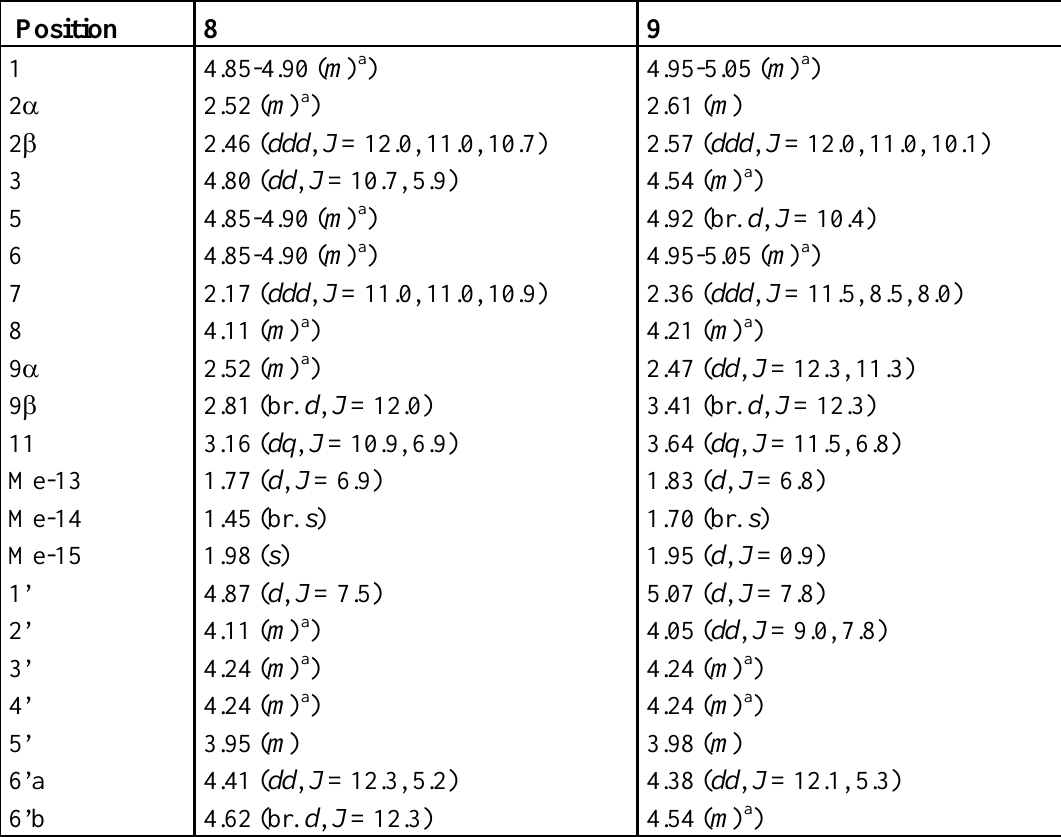
; δ in ppm, J in 5 H